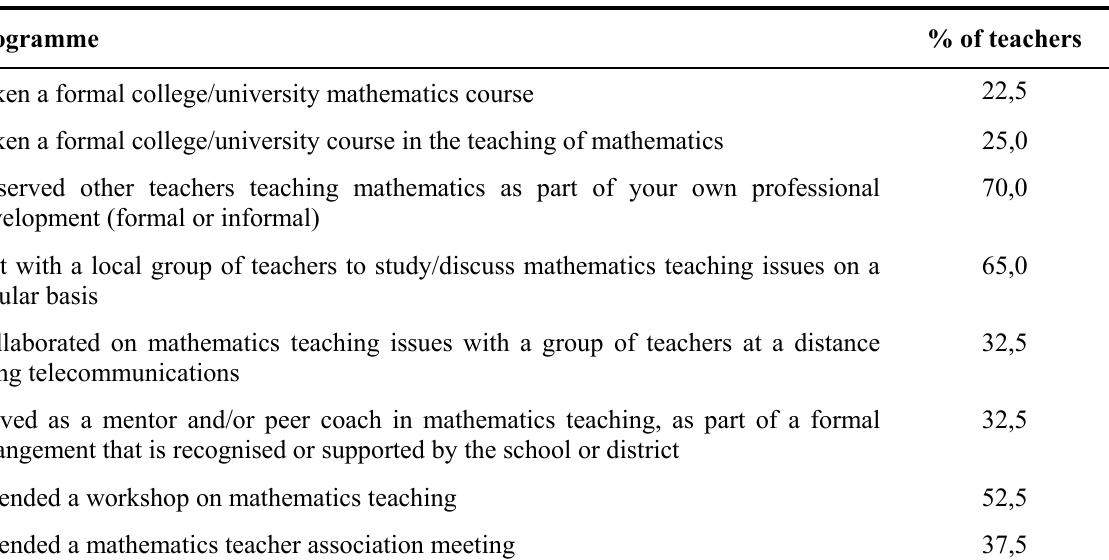
Table 6 : Teachers’ participation in professional development programmes (N =